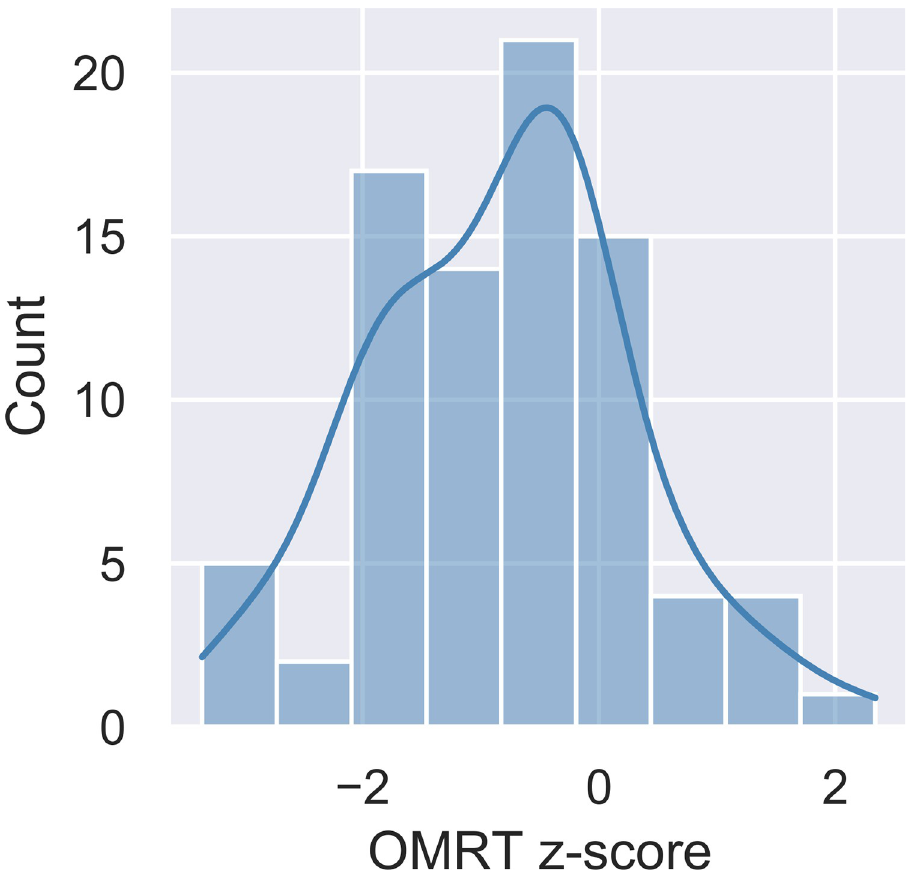
Fig 1. Distribution of the OMRT z-score in the